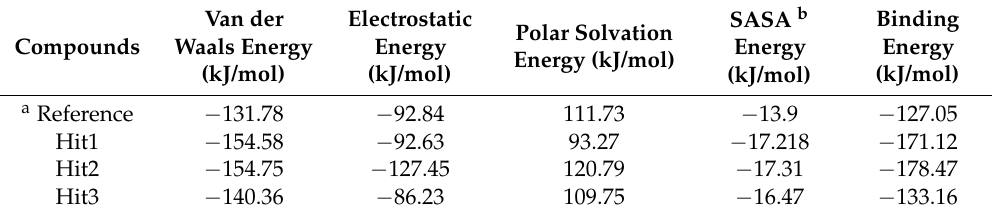
Table 7. Decomposition of binding free energy.